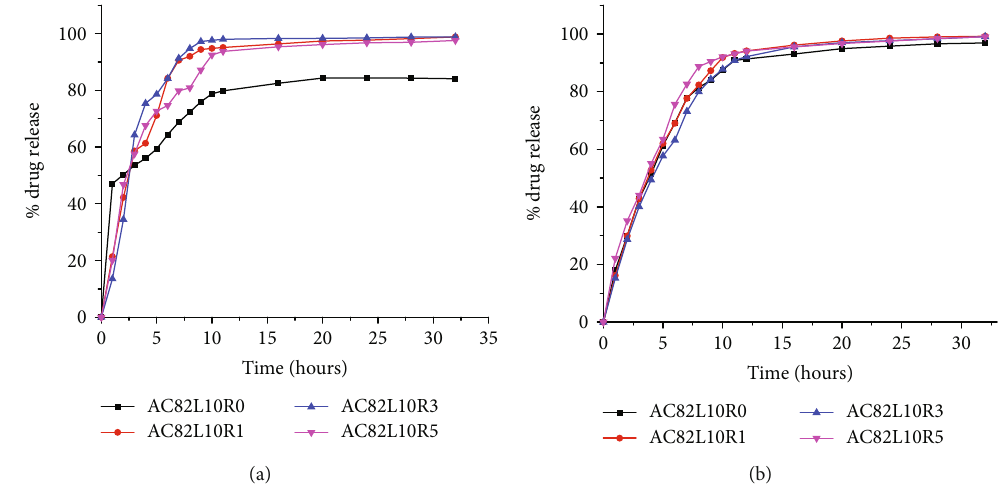
Figure 4: Content of LOV released from AC82L10R x composite fi lms in pH 2 and pH 4.5 bu ff ers. Table 3: The content of LOV and Rb1 released from AC82L10R x composite fi lms in pH 2 solution. Content of released LOV Time